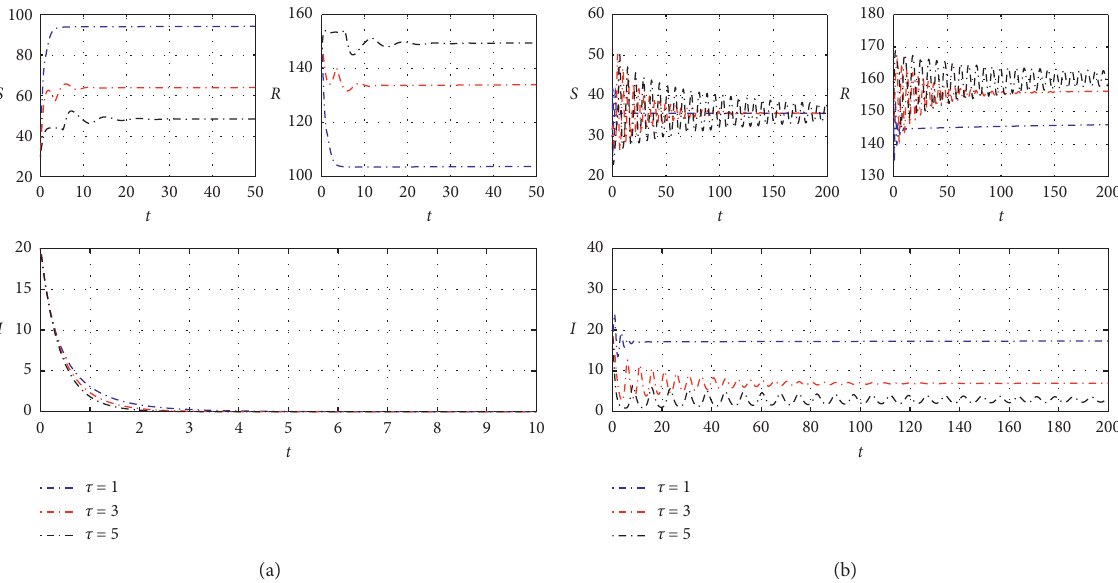
Figure 2: The impact of τ on the number of the susceptible computers S ( t ) , the infected computers I ( t ) , and the recovery computers R ( t ) : ( τ ) < 1; (b) R ( τ ) > 1. (a) R 0 0